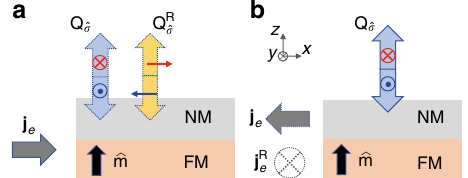
Fig. 1 Spin – orbit effects with conventional and rotated symmetries. a Spin currents generated from a charge current near the FM/NM interface. The red and dark blue arrows represent spins. The light blue and yellow arrows represent the spin current with conventional symmetry, Q ^ σ , and the spin current with spin-rotation symmetry, Q R ^ σ , respectively. The gray arrow represents the charge current j e . b A sketch of the reciprocal process to illustrate how the conventional and rotated charge currents are generated by a pure spin current near the FM/NM